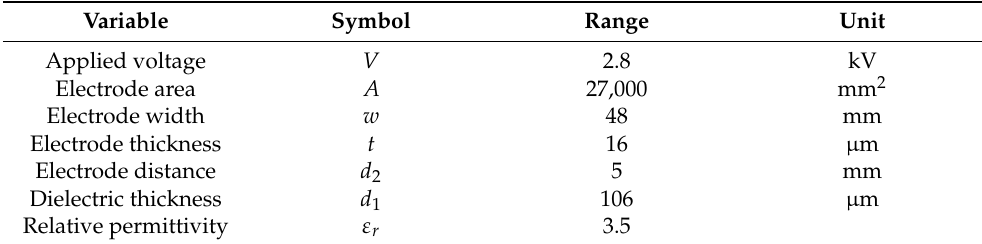
Table 7. Specification of the optimal electroadhesion pad used in the Ansys Maxwell.